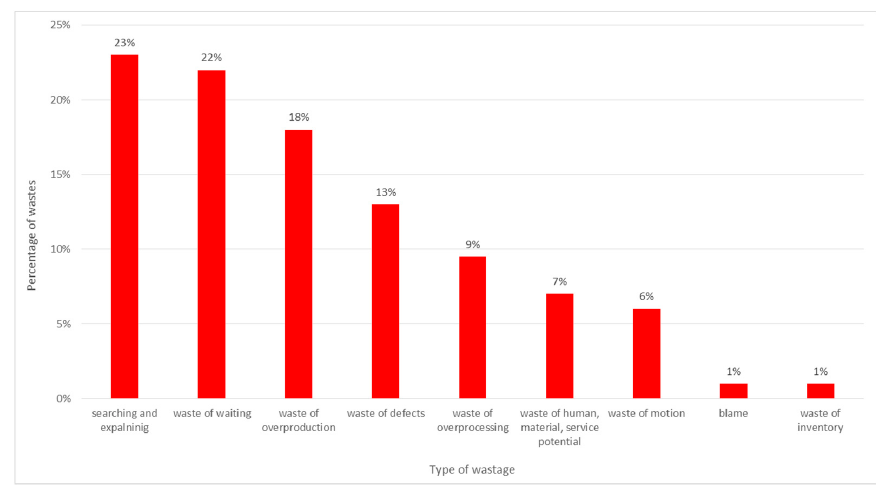
Figure 6. Identified wastes. Source: own study based on the hospital materials. The analysis identified a total of 137 different problems. Their distribution into nine groups and a proposal of possible solutions is presented in Table 1. Table 1. A distribution of wastes and proposed solutions by groups. Number of Proposed Type of Waste Number of Identified Wastes